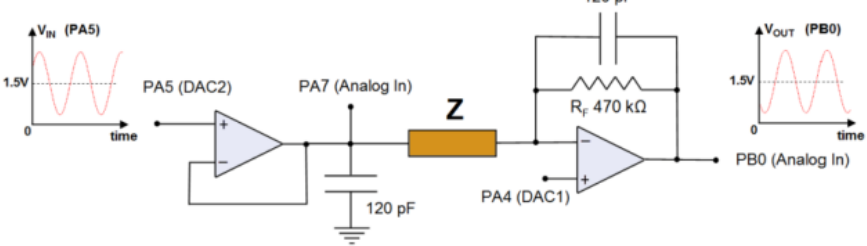
Figure 2. Schematic of the circuit for the measurement of the emulsion electrical conductance. Reprinted with permission from Ref. [23]. 2022 Elsevier.